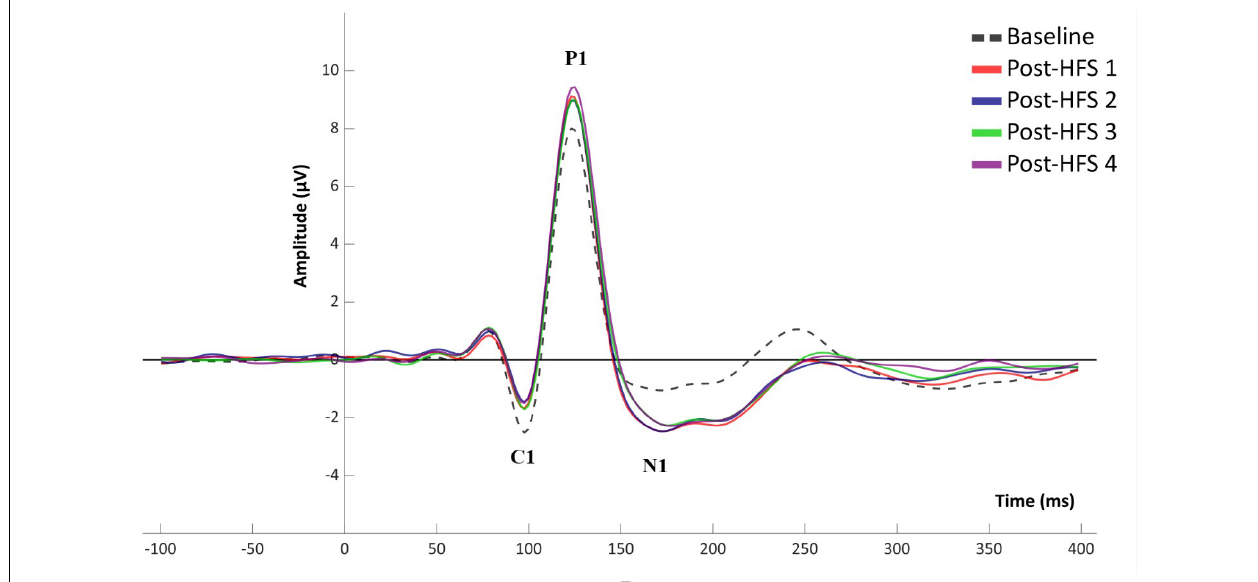
FIGURE 2 | Grand average ( n = 110) VEP waveform for baseline and post-HFS